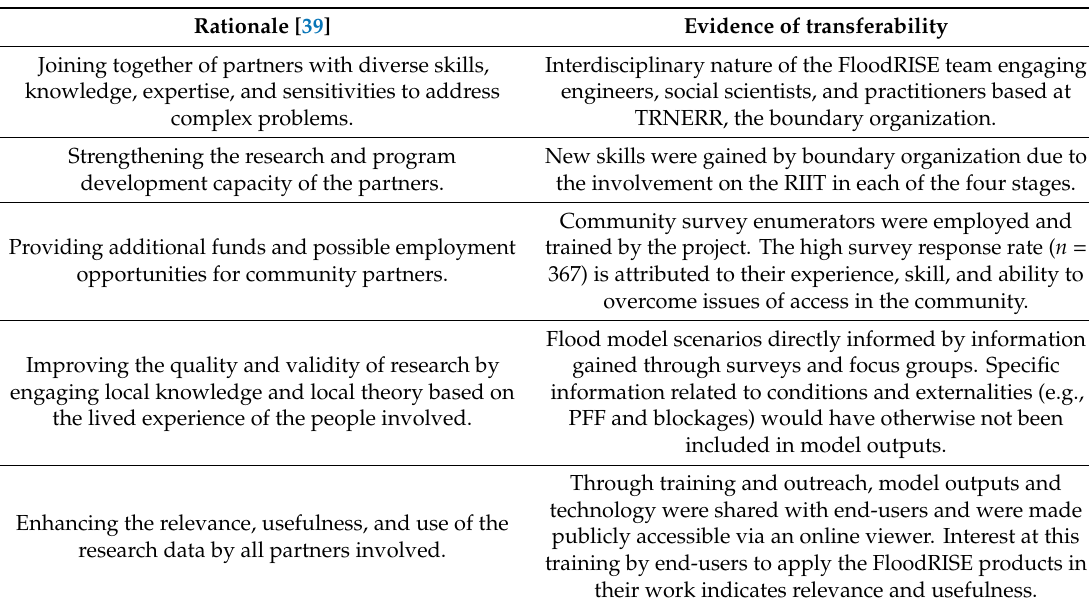
Table 1. Evidence of transferability of community-based research rationale in the Flood Resilient Infrastructure and Sustainable Environments (FloodRISE) project. TRNERR: Tijuana River National EstuarineResearchReserve, RIIT:ResearchIntegrationandImpactTeam,